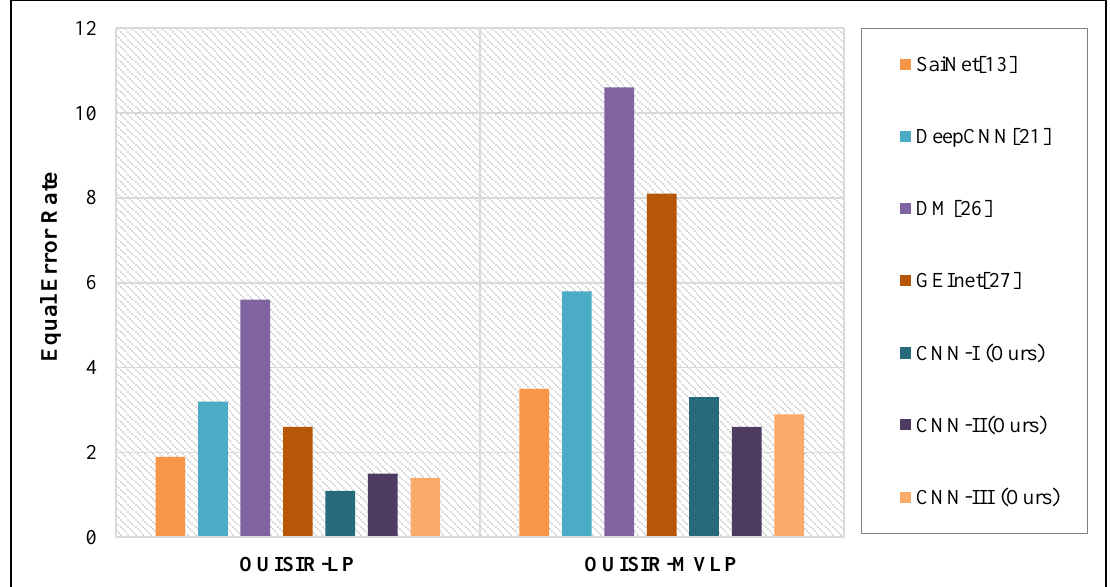
Figure 4. Comparison of EER with other